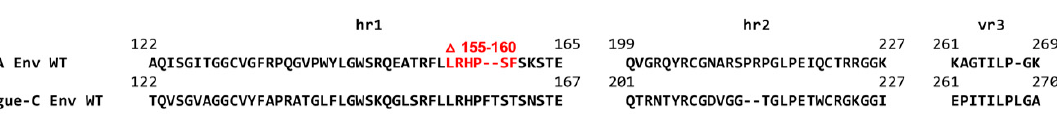
Figure 1. Comparison of the subgroup A and subgroup C avian sarcoma and leukosis viruses (ASLV) envelope glycoprotein hr1, hr2, and vr3 hypervariable regions. The protein sequence alignments were done using the ClustalW program in MacVector 14.5.3; gaps in the alignment are denoted by ( − ). The RCASBP(A) vector contains the envelope glycoprotein hypervariable regions from the Schmidt-Ruppin A subgroup A ASLV strain (SR-A Env WT) UniProt P03397; the RCASBP(C) vector contains the envelope glycoprotein hypervariable regions from the Prague-C subgroup C ASLV (Prague C Env WT) Genbank AAB59934.1. The RCASBP(A) ∆ 155–160 six residue deletion is highlighted in red.